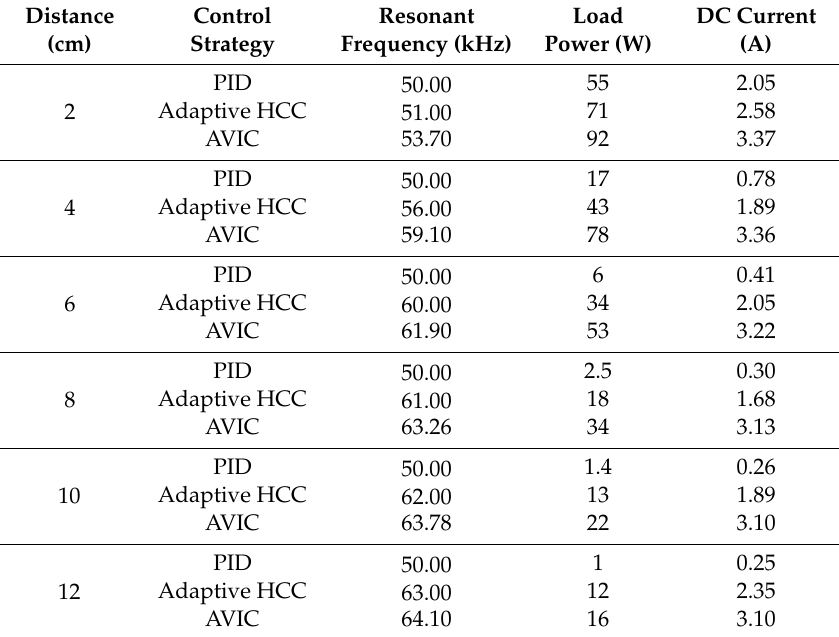
Table9. Comparativeanalysisbetweenproportionalintegralderivative(PID),adaptivehysteresis-based current control (HCC), and adaptive virtual impedance controller (AVIC).